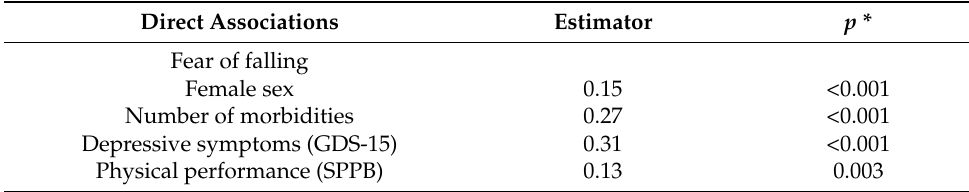
Table 3. Direct standardized coefficients for variables associated with greater fear of falling among older adults in Macap á , Amap á , Brazil, 2017 ( n =